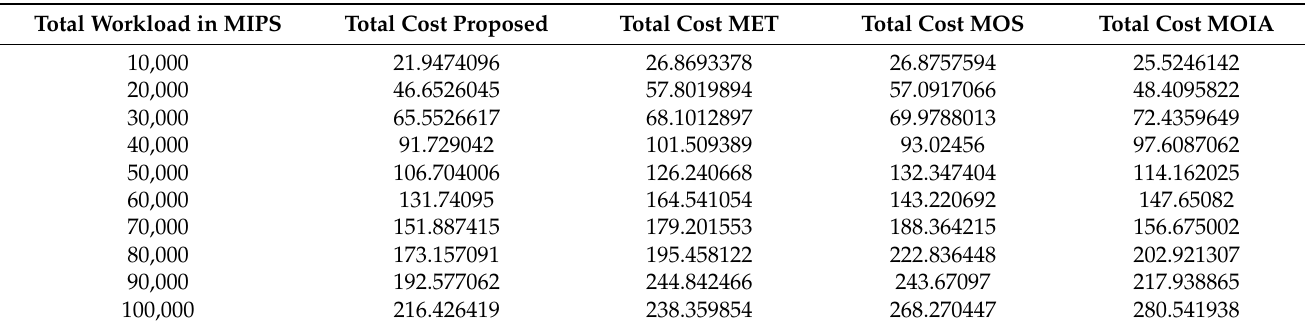
Table 5. Overall cost of proposed vs. state of the art techniques.